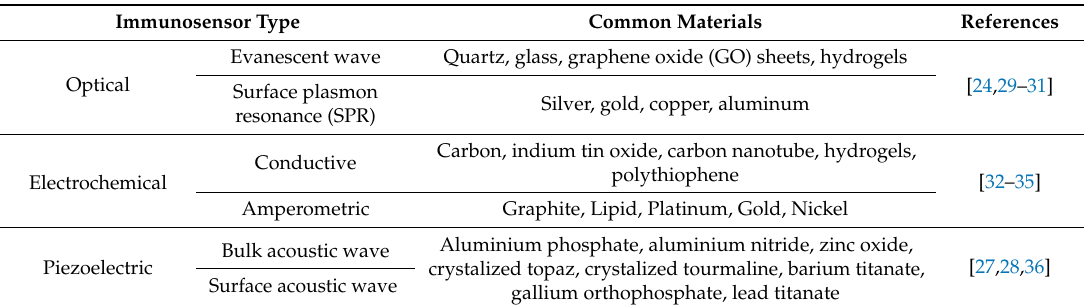
Table 1. Immunosensor types and common materials used.